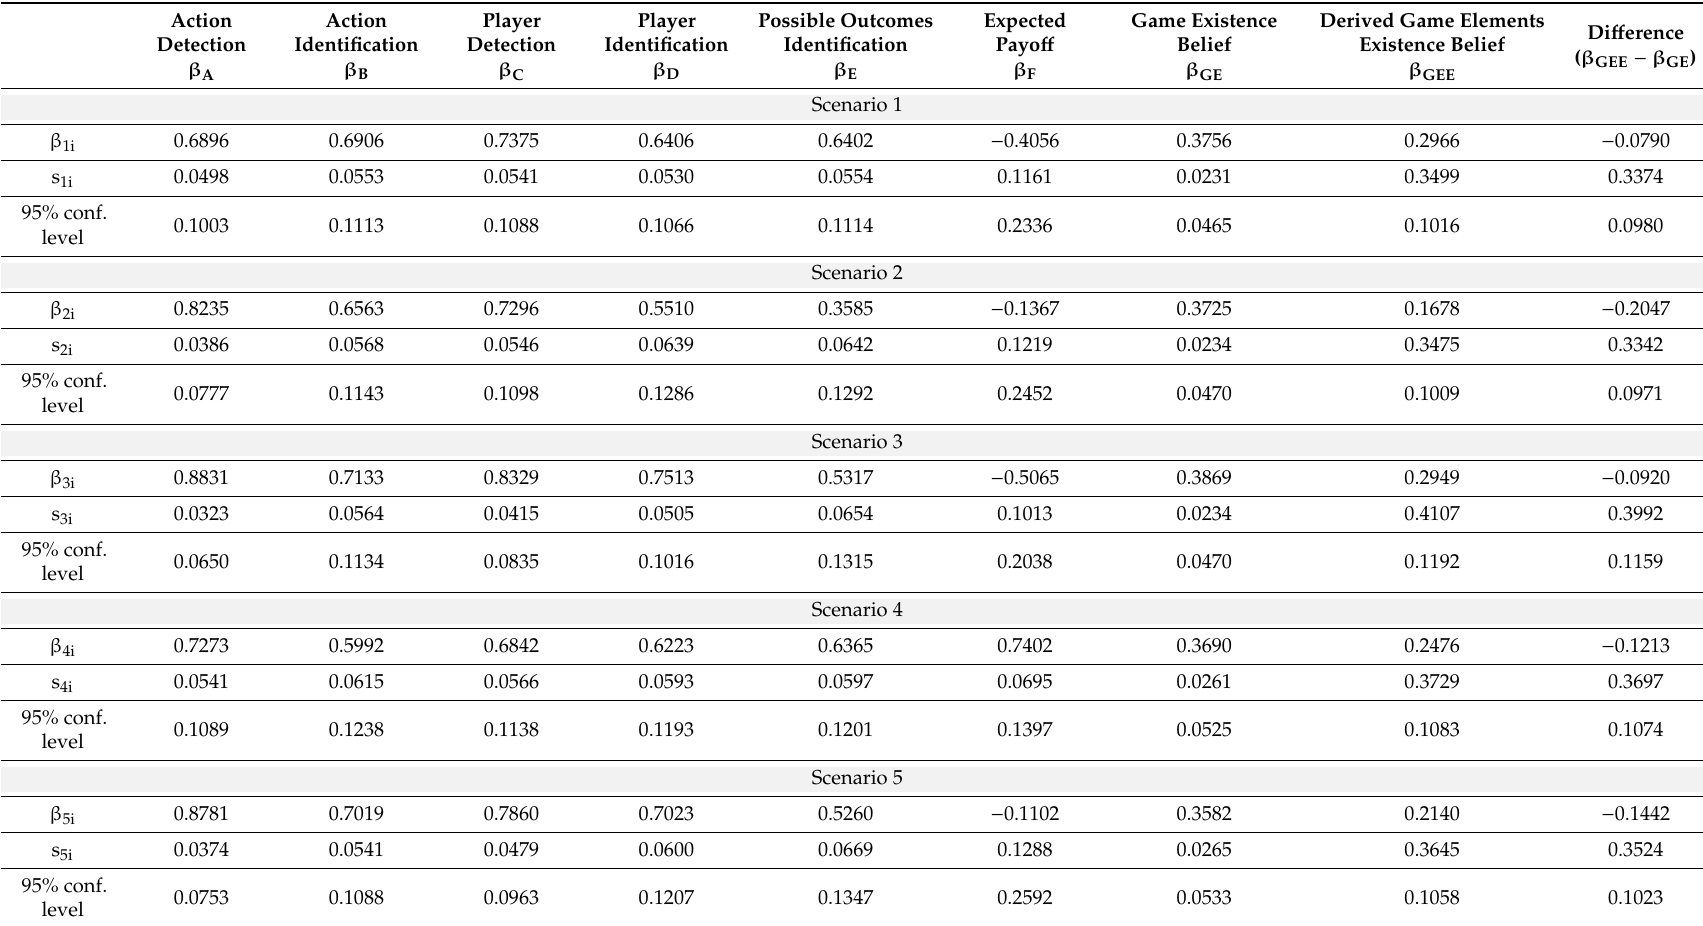
Table 4. Descriptive statistics of the